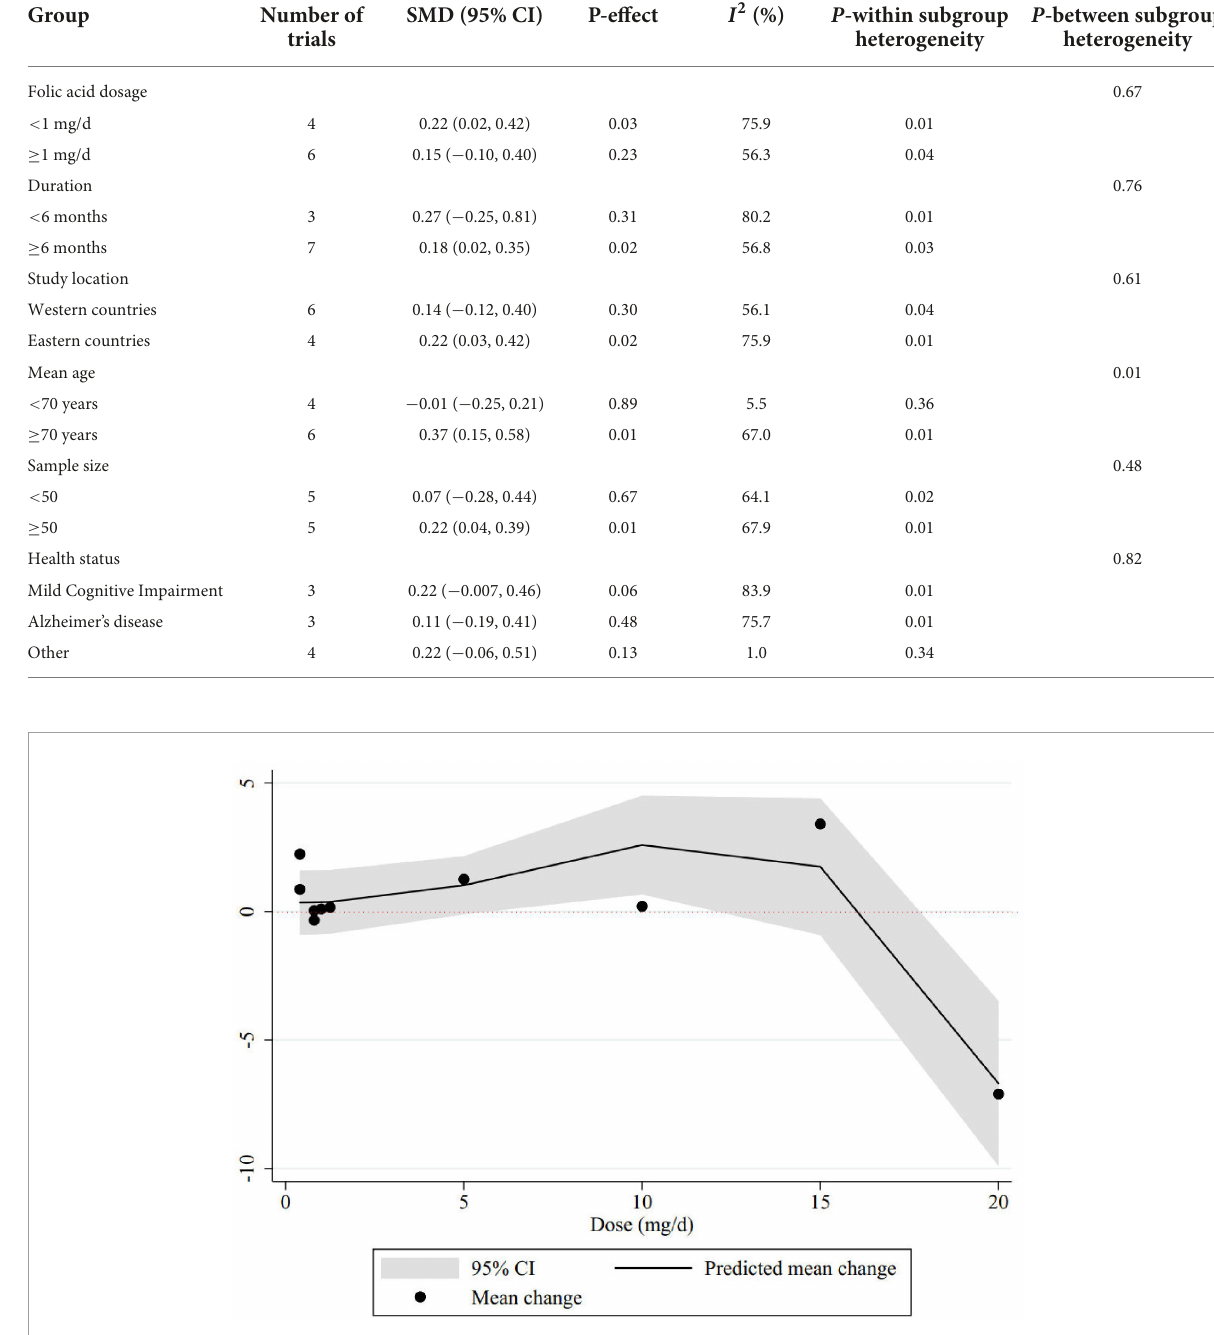
FIGURE3 Non-linear dose-response relations between folic acid dosage (mg/d) and memory. The 95% CI is revealed in the shaded